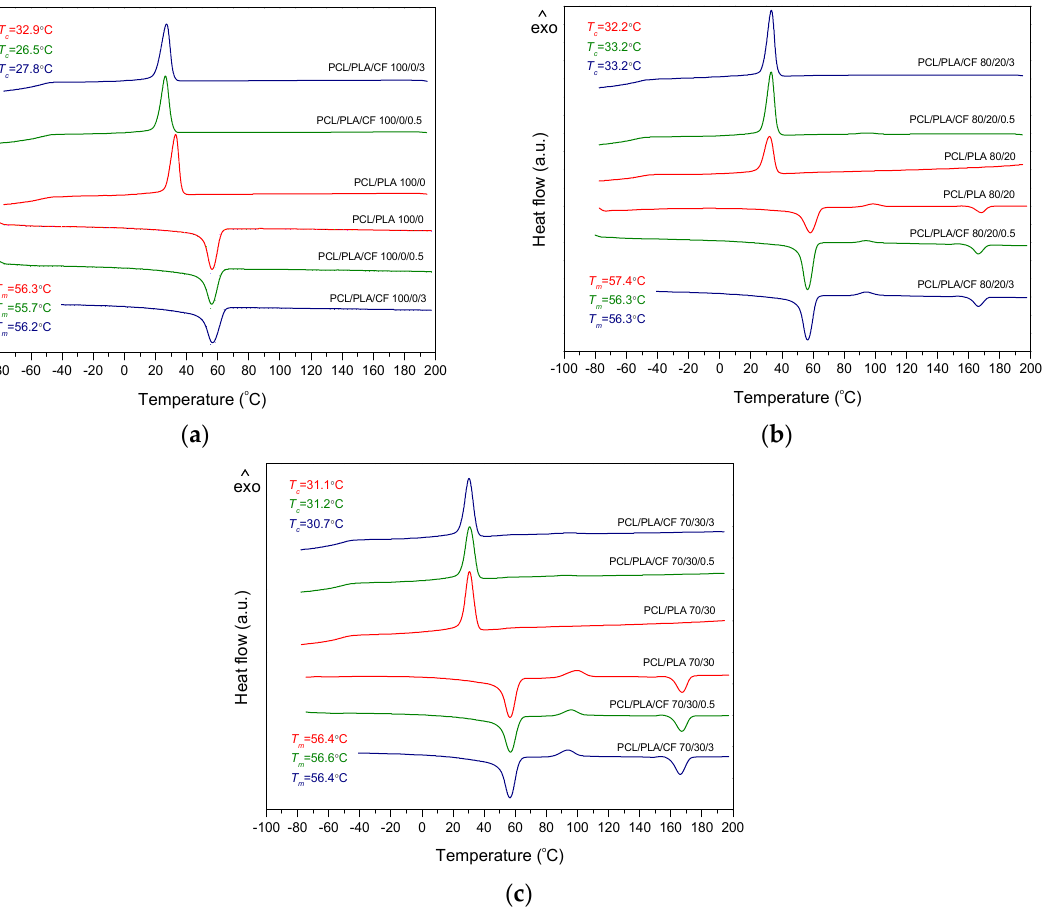
Figure 2. DSC thermograms of PCL/PLA/CF blends during the cooling and second heating cycle: ( a ) 100/0/0, 100/0/0.5, 100/0/3.0; ( b ) 80/20/0, 80/20/0.5, 80/20/3.0 and ( c ) 70/30/0, 70/30/0.5, 70/30/3.0. Table 3. DSC data for the cooling and second heating cycle of PCL/PLA/CF blends.